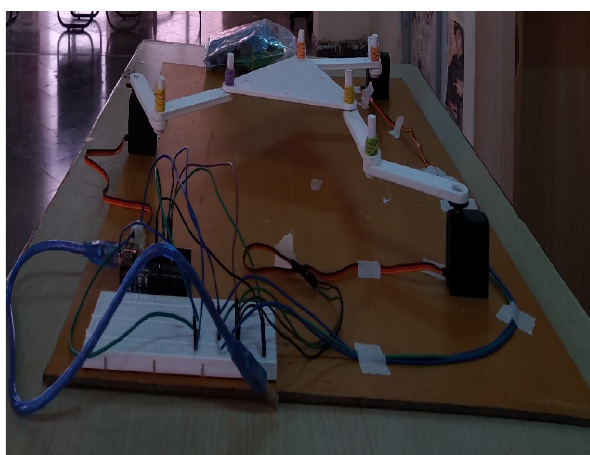
Figure 4 & 5. An Isometric view of the prototypes